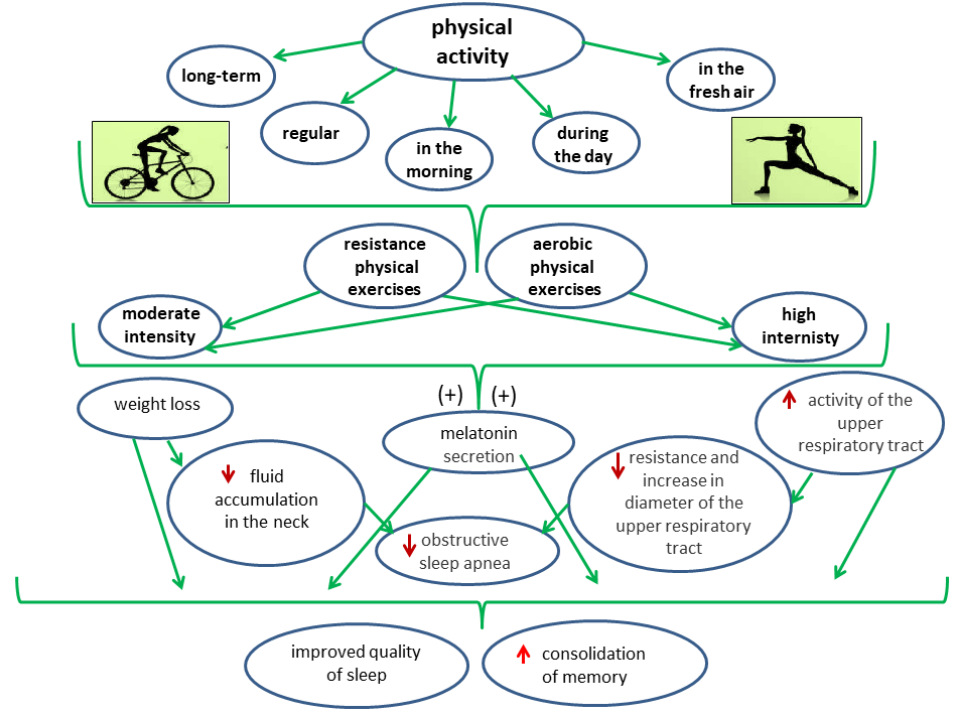
Figure 6. Effects of physical activity on sleep quality.